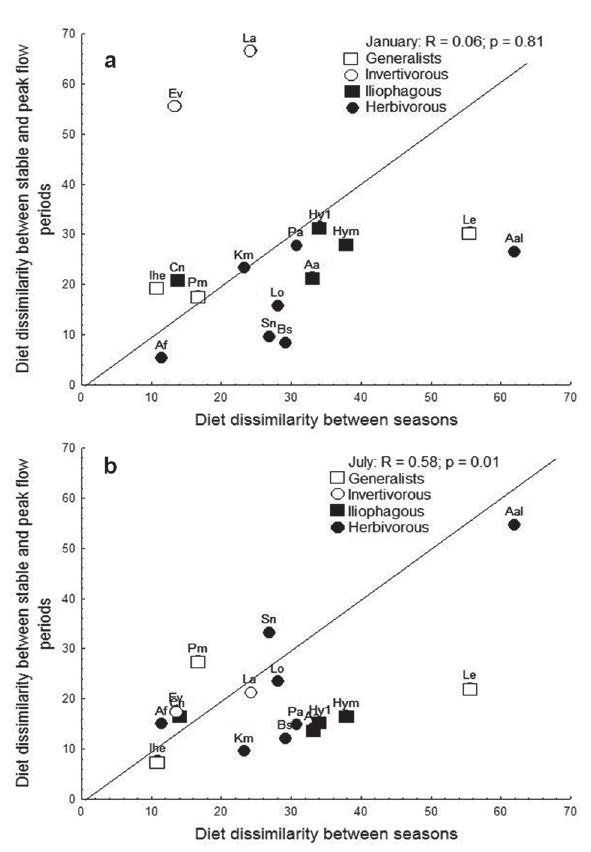
Fig. 4. Relationship among the diet dissimilarity between seasons and diet dissimilarity stable and hydropeaking treatments in January (a) and July (b). Line is representing a linear correlation. Correlation values (r and p) are indicated. Aa= Apareiodon affinis ; Aal= Astyanax altiparanae ; Af= Astyanax fasciatus ; Bs= Bryconamericus stramineus ; Cn= Cyphocharax nagelii ; Ev= Eigenmmania virescens ; Hy1= Hypostomus sp.1; Hym= Hypostomus aff. margaritifer ; Ihe= Iheringichthys labrosus ; Km= Knodus moenkhausii ; La= Leporinus amblyrhynchus ; Lo= Leporinus octofasciatus ; Pa= Piabina argentea ; Pm= Pimelodus maculatus ; Sn= Schizodon nasutus .